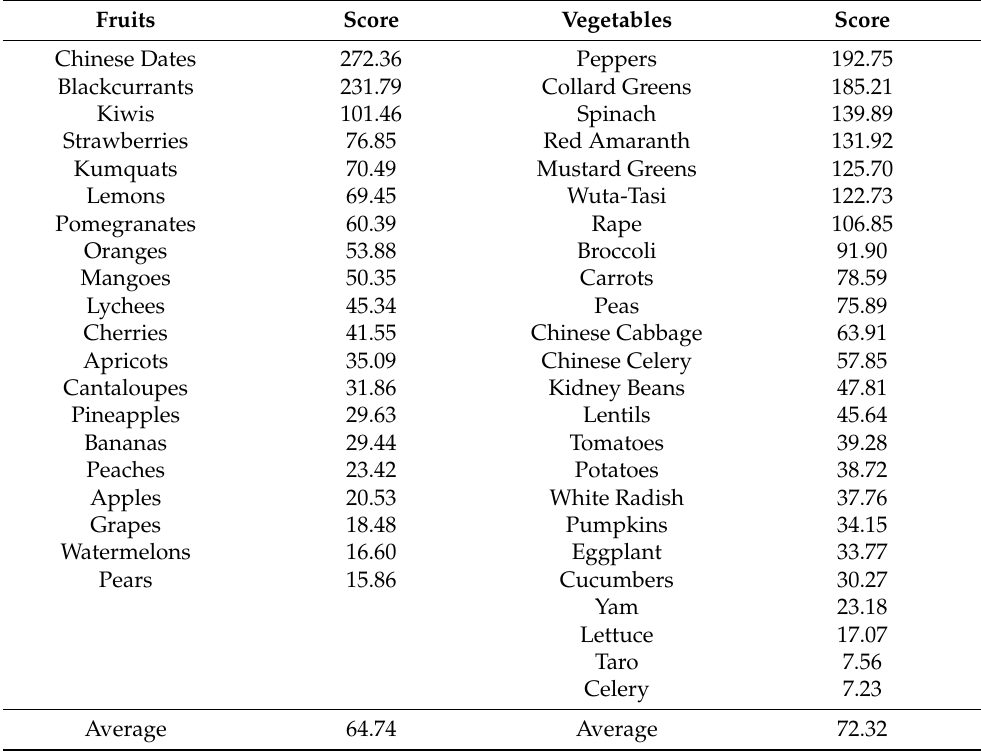
Table 5. The NRF9.3 score results of 20 fruits and 24